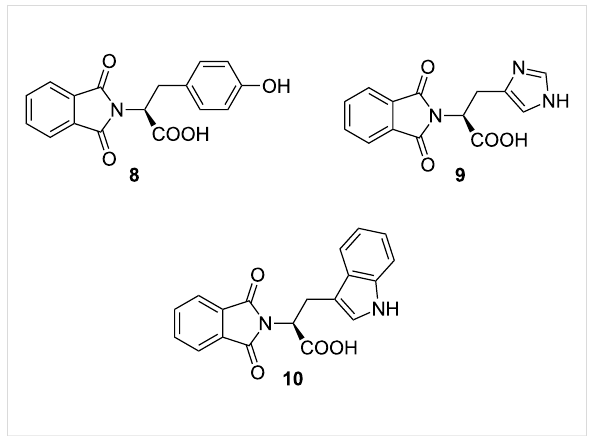
Figure 1: Phthalimides from tyrosine 8 , histidine 9 and tryptophan 10